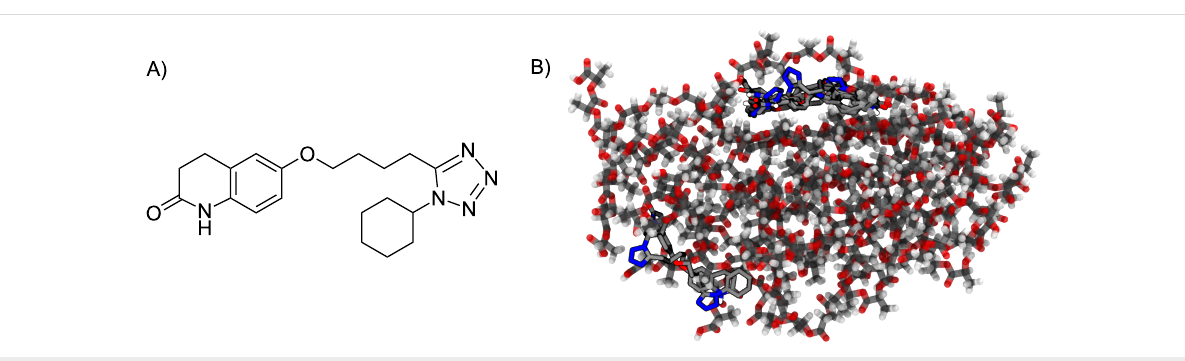
Figure 6: A) 2D structure of cilostazol. B) Main putative binding sites of cilostazol docked into the PLA core. The PLA core is represented with conventional color coding and the chains are displayed slightly transparent. Cilostazol poses are represented in sticks.